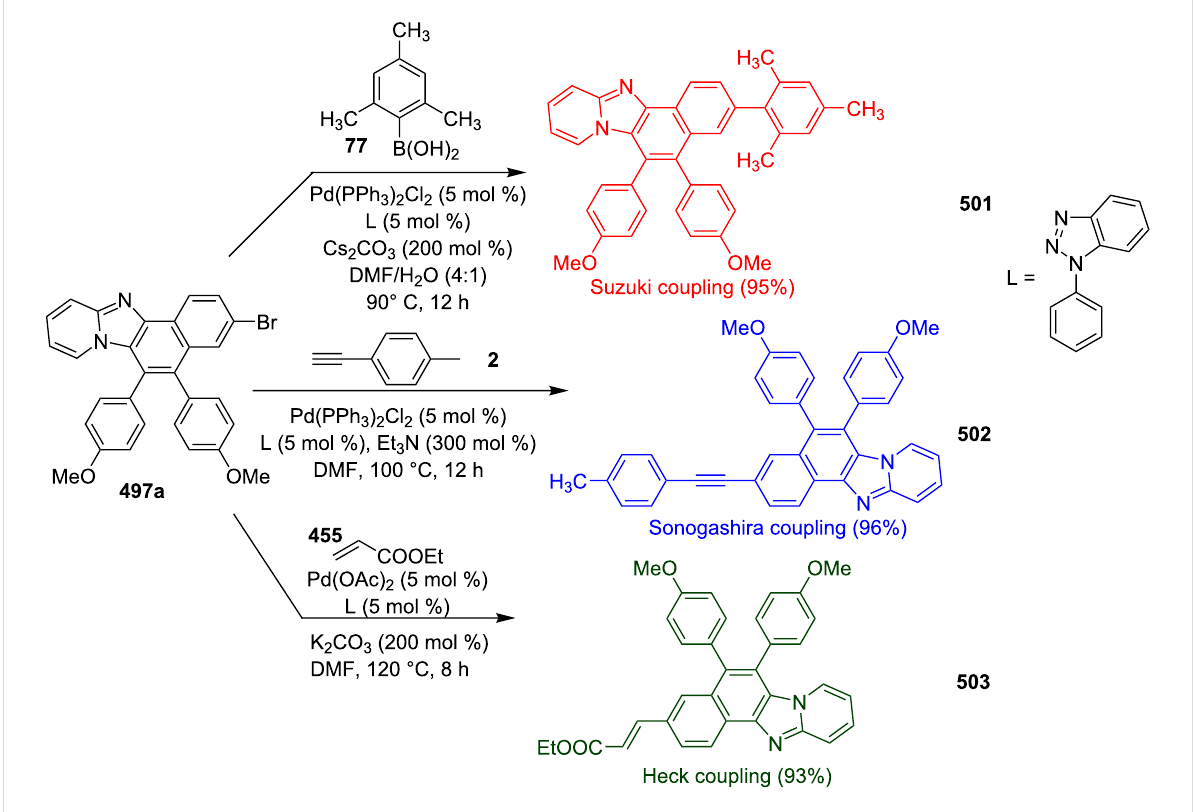
Scheme 175: Reactions showing functionalization of the product obtained by the group of Kotla.